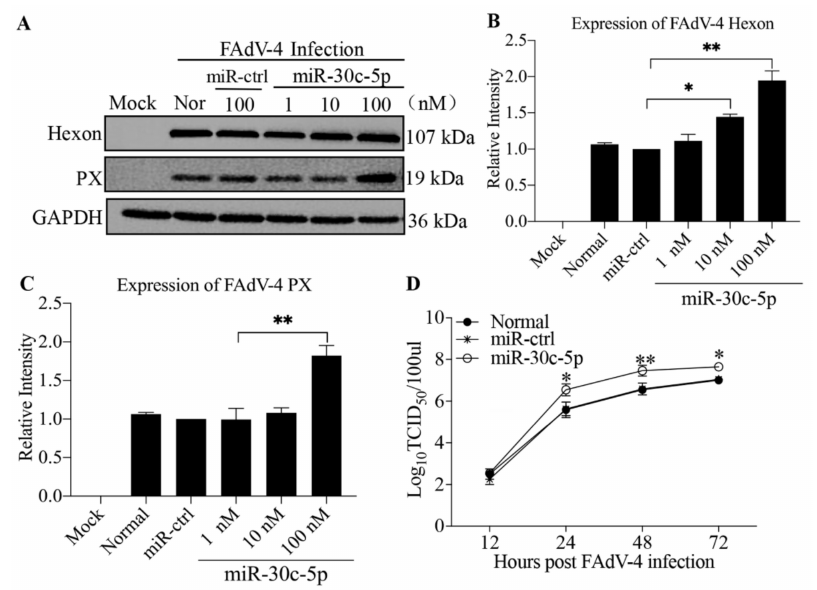
Figure 3. gga-miR-30c-5p facilitates FAdV-4 replication in LMH cells. ( A – C ) The LMH cells were transfected with gga-miR-30c-5p mimics or controls at different concentrations. Twenty-four hours after transfection, the cells were infected with FAdV-4 at an MOI of 1. Twenty-four hours after FAdV-4 infection, cell lysates were prepared and subjected to Western Blot analysis using anti-Hexon and anti-PX antibodies. Endogenous GAPDH expression was examined as an internal control. The band densities of Hexon and PX shown in panel ( A ) were quantitated by densitometry, as shown in panels ( B , C ). The relative levels of Hexon and PX were calculated as follows: band density of Hexon or PX/that of GAPDH. ( D ) The LMH cells were transfected with gga-miR-30c-5p mimics or miRNA controls. Twenty-four hours after transfection, the cells were infected with FAdV-4 at an MOI of 1. At different time points (12, 24, 48, and 72 h) after FAdV-4 infection, the viral loads in the cell cultures were determined by TCID 50 assays. The significance of the differences between gga-miR-30c-5p-transfected cells and controls in terms of viral growth was determined by ANOVA. Data are representative of three independent experiments and presented as means ± SD. (** stands for p < 0.01; * for p <